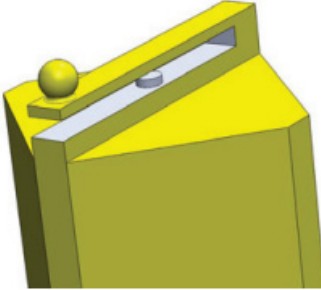
Figure 8. Ferrule-top cantilever for Casimir force measurements Figure 8. Ferrule ‐ top cantilever for Casimir force measurements [68].